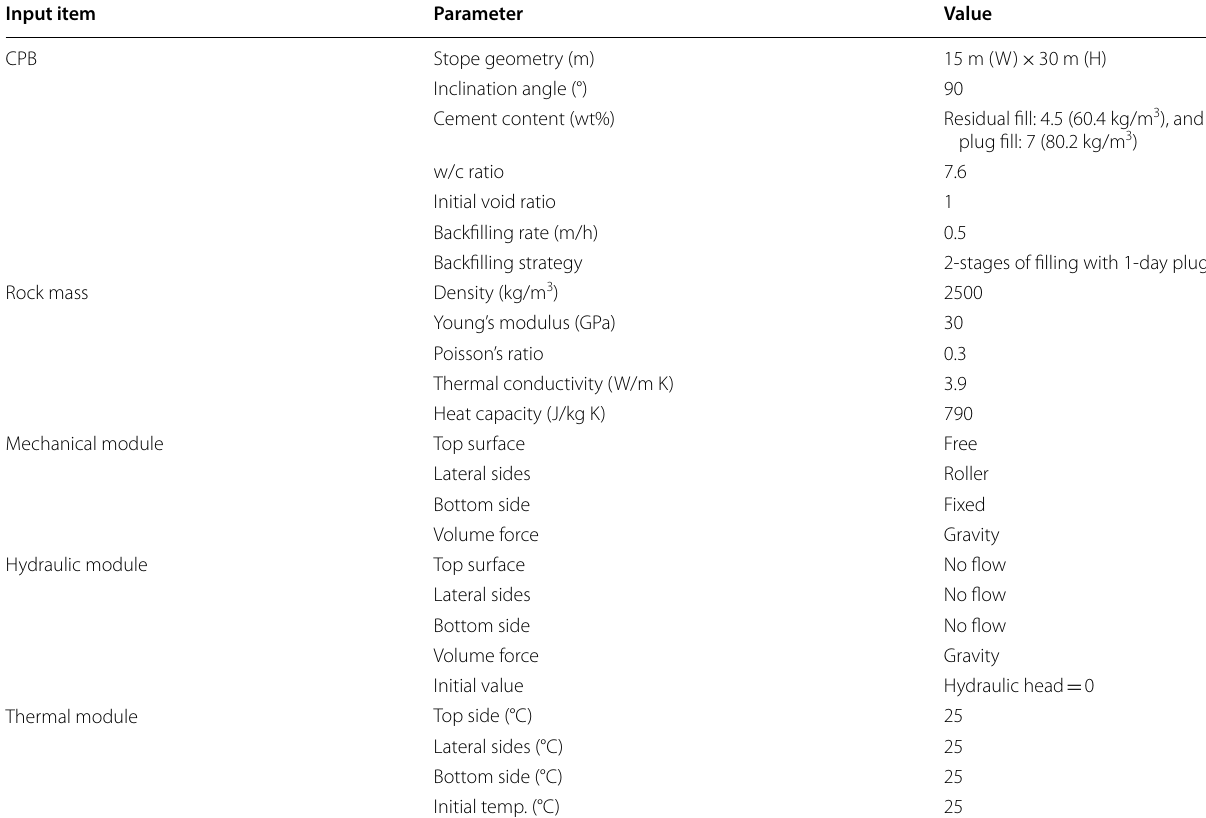
wt% weight percentage with respect to the total weight of the solid phase in CPB